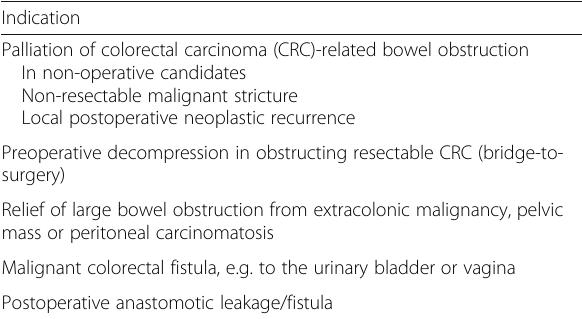
Table 1 Indications for stent management of colorectal disorders Indication